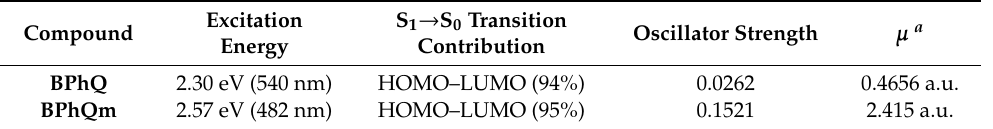
Table 3. Photophysical parameters obtained by TD-DFT / B3LYP / 6-311 + G(d,p) based on the optimized geometries in the S 1 state.